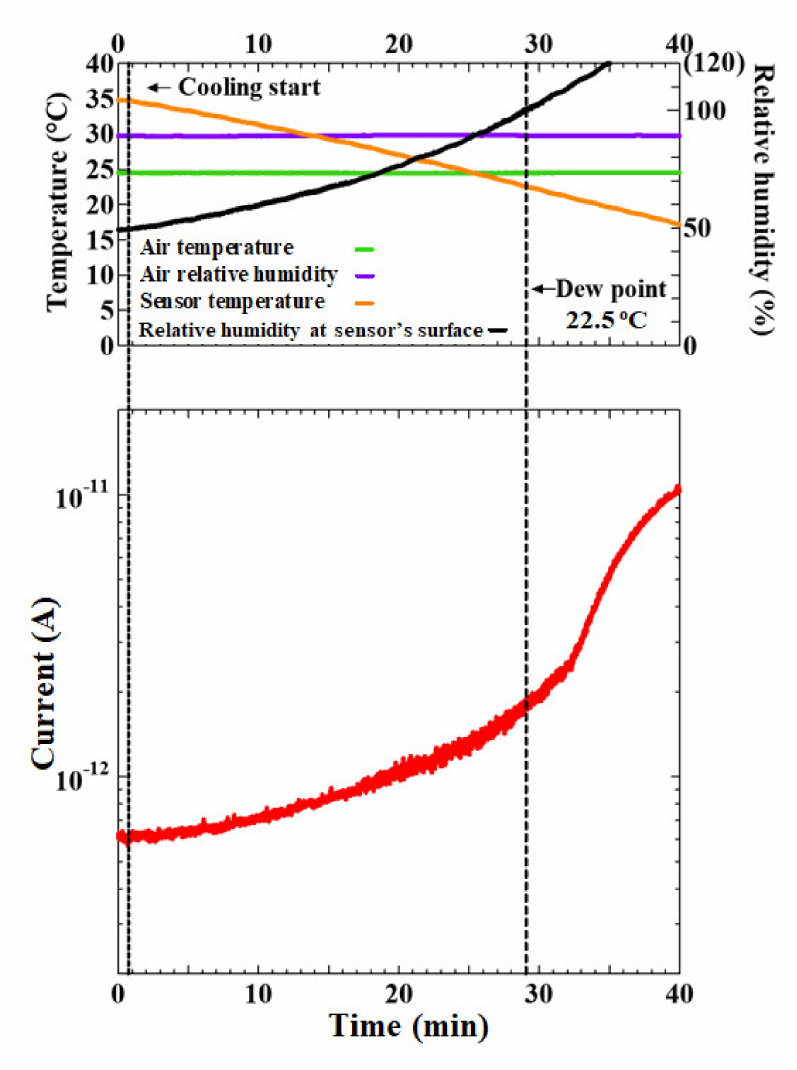
Figure 4. Output current over time (red line) as the sensor’s surface was cooled from 35 ◦ C to ≈ 0 ◦ C at 0.5 ◦ C / min, at 1.54 kPa vapor pressure, and with a 90% relative humidity inside the measurement